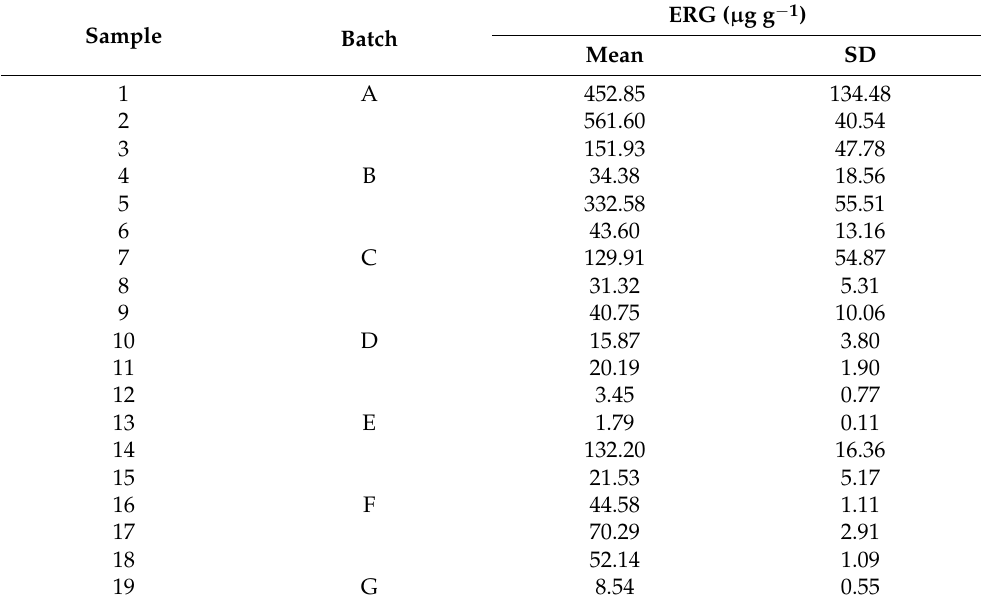
Table 3. Concentration of ergosterol (ERG, µ g g − 1 DW) for sample. Values are given as samples mean ± SD (standard deviation, n = 3).